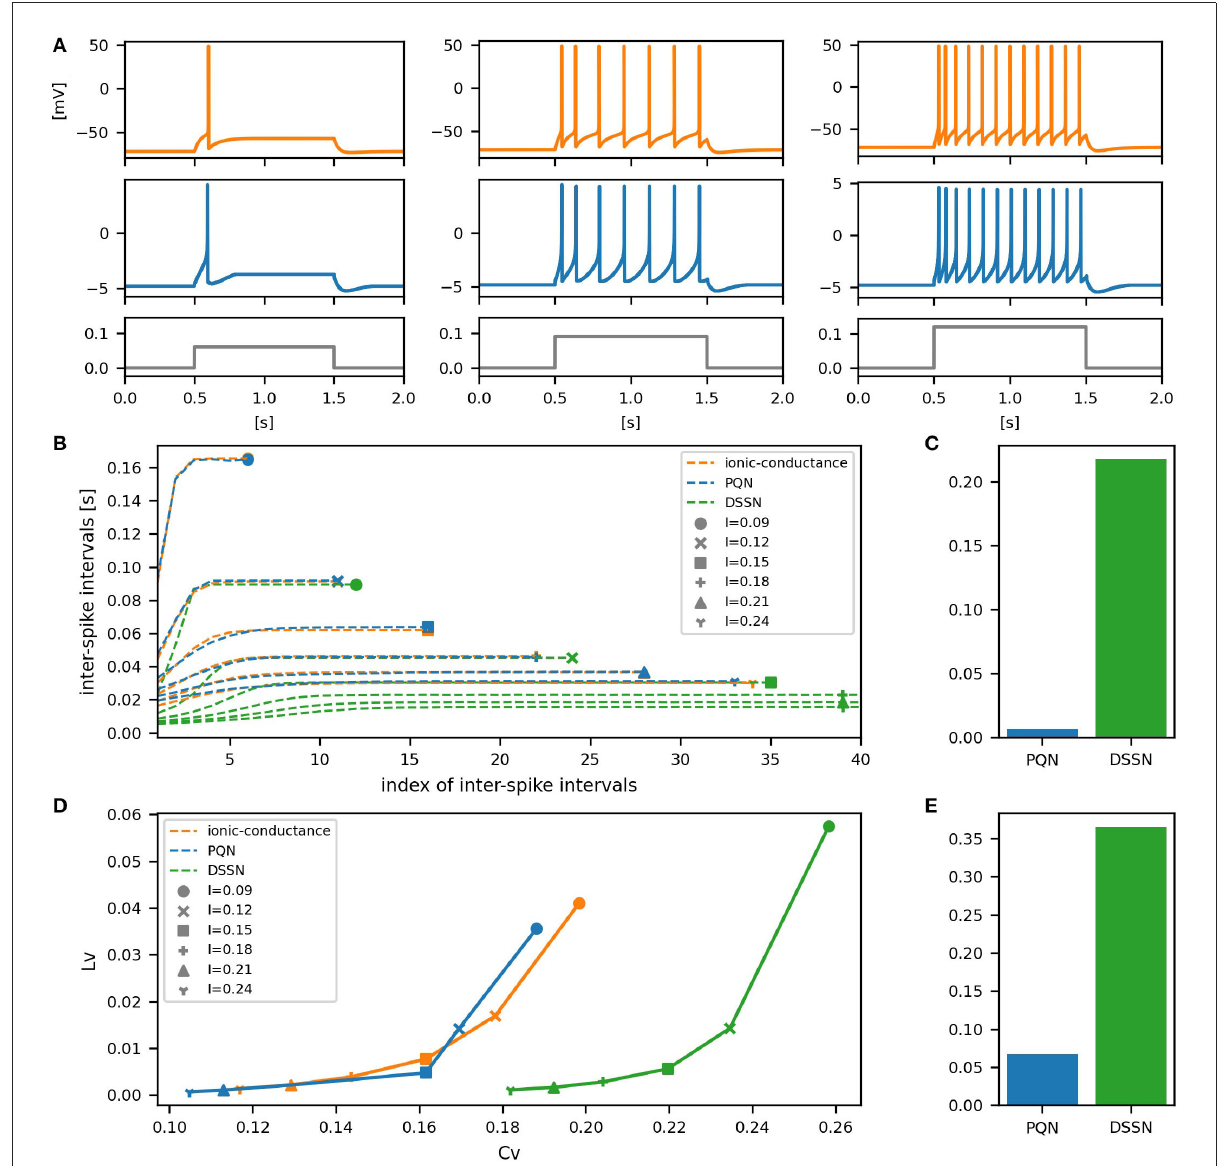
FIGURE6 Waveforms and spiking properties in excitatory RS mode. (A) Waveforms of the ionic-conductance model (orange) and the PQN model (blue). Gray lines represent stimulus inputs, whose unit in the ionic-conductance model is nA. In the PQN model, they have no physical unit. (B) The transitions of ISIs are shown while increasing the magnitude of the stimulus input. The horizontal axis represents the index of the ISIs, and the vertical axis represents the magnitude of the ISIs. Orange, blue, and green lines represent the ionic-conductance, PQN, and DSSN models, respectively. Markers were plotted to show the corresponding magnitude of the stimulus input. (C) The mean square errors of the PQN model and the DSSN model with the ionic-conductance model over the data points shown in (B) . (D) Values of the C V and L V were calculated from the waveforms and plotted while varying the magnitude of the stimulus inputs. The waveforms used here are the same as that used in (B) . (E) The mean square errors of the PQN model and the DSSN model with the ionic-conductance model over the data points shown in (D) .